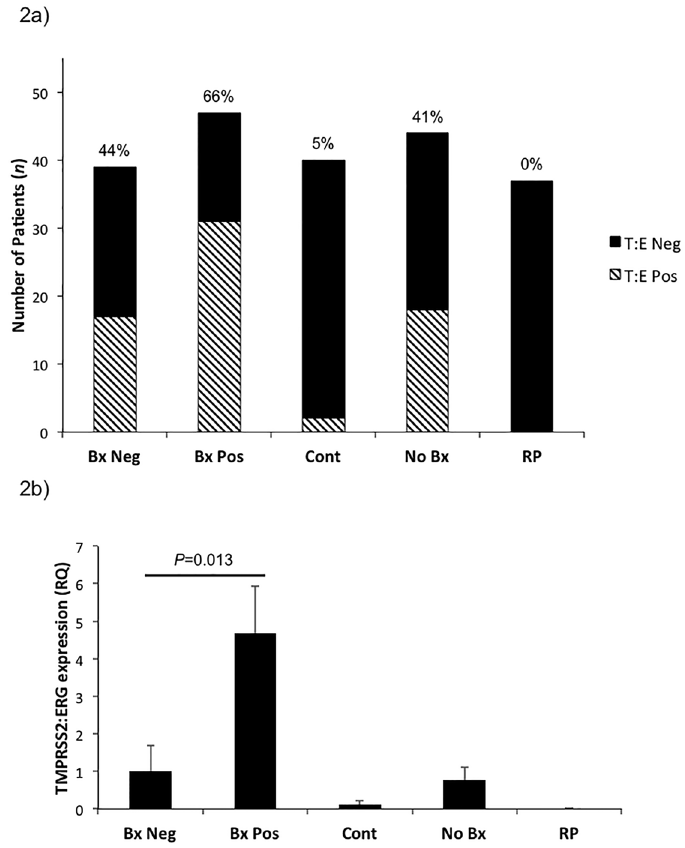
Fig 2. Non-invasive Analysis of the Incidence of TMPRSS2:ERG Fusion using Urinary EV exoRNA. a) Rate of TMPRSS2:ERG detection in urinary EVs. Lined bars — TMPRSS2:ERG positive, solid bars — no TMPRSS2:ERG expression. Percentage refers to TMPRSS2:ERG positive patients. b) Relative quantitation (RQ) of TMPRSS2:ERG expression versus Bx Neg patients. TMPRSS2:ERG expression was standardized to KLK3 consistent with other prostate biomarker studies [20]. Bx Neg — biopsy negative (n = 39), Bx Pos — biopsy positive (n = 47), Cont — control males < 35 years old (n = 40), No Bx — no biopsy (age matched control) (n = 44), RP — radical prostatectomy (n = 37). Data presented as RQ ±